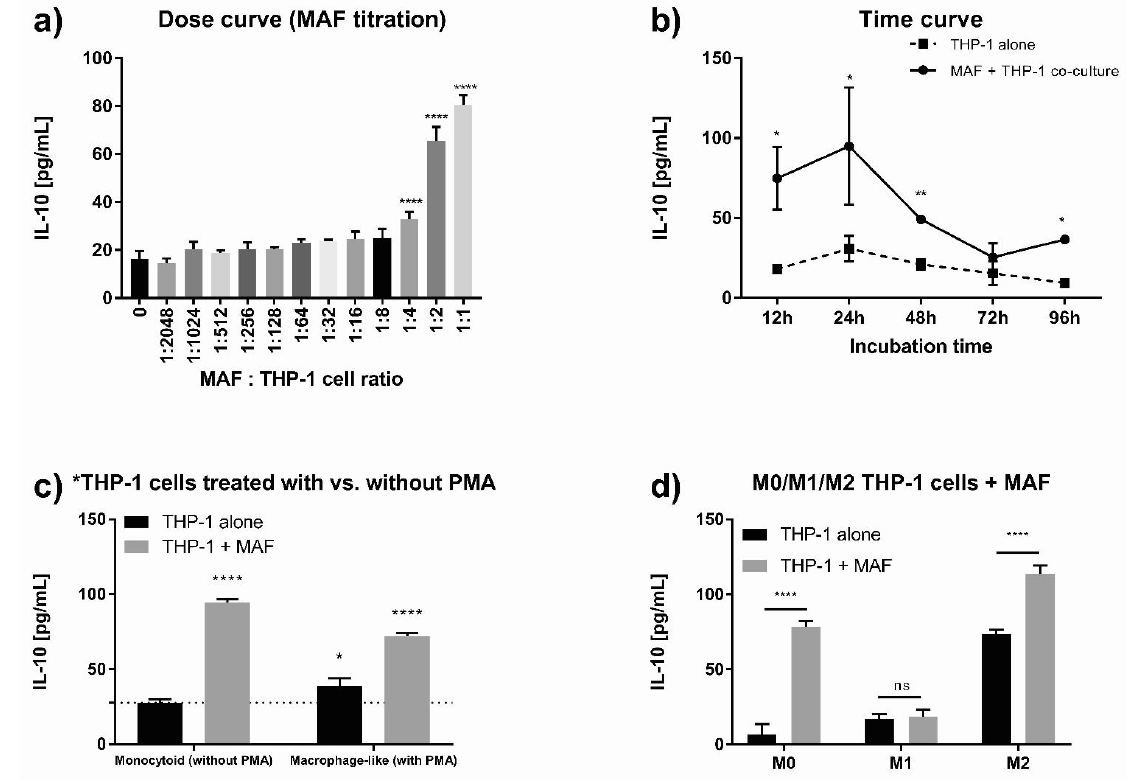
Figure 5. Effect of MAFs on IL-10 secretion in THP-1 macrophages. ( a ) IL-10 concentration of MAF-THP-1 co-cultures with a MAF/macrophage cell ratio between 1:2048 and 1:1, n = 4. ( b ) IL-10 concentration of THP-1 monoculture and MAF/THP-1 co-culture at 12 h, 24 h, 48 h, 72, and 96 h of incubation time, n = 4. ( c ) IL-10 concentration of monocytoid (without PMA pretreatment) and macrophage-like (with PMA pretreatment) THP-1 cells in monoculture and co-culture with MAFs, n = 6. ( d ) IL-10 concentration of M0-, M1-, and M2-like differentiated THP-1 macrophages in monoculture and co-culture with MAFs, n = 5. Error bars represent means ± s.e.m. * p < 0.05, ** p < 0.005, and **** p < 0.0001.